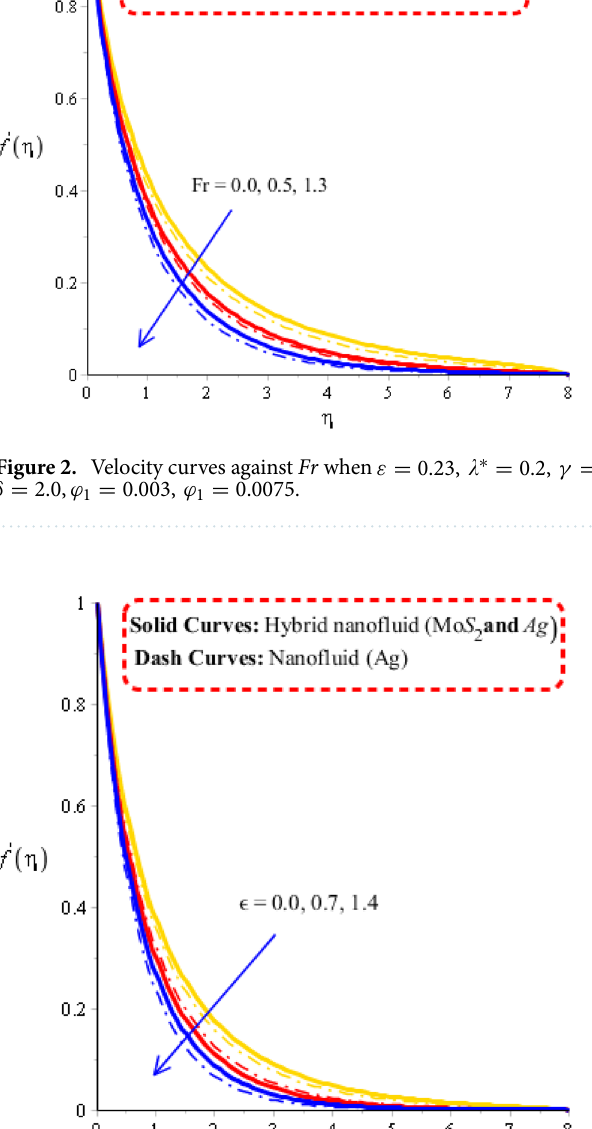
1.3, γ 0.7, Fr 0.31, Pr 204, Hs 1.5, (cid:31) 1.3, = = = = = =